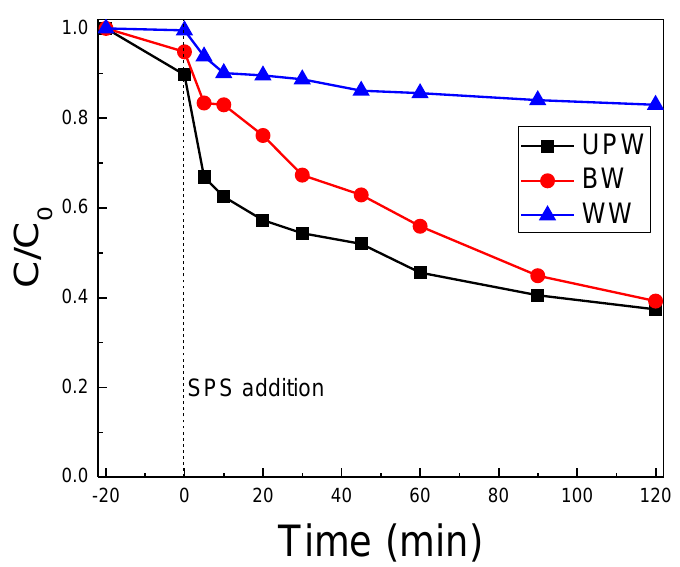
Figure 8. Effect of water matrix on 500 mg L − 1 SMX degradation with 500 mg L − 1 RHB700 and 500 mg L − 1 SPS and inherent pH.